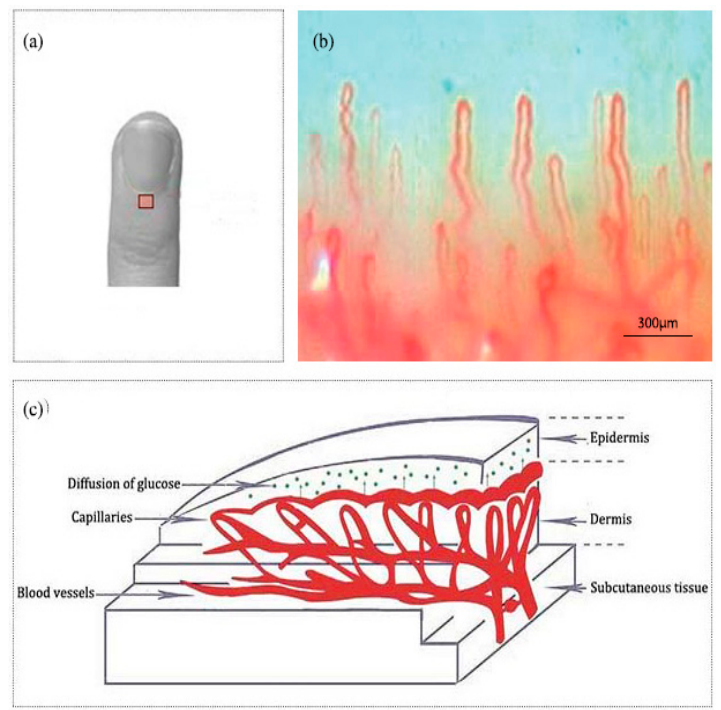
Figure 1. ( a ) A nailfold for the fourth finger including an area to be scanned. ( b ) The image of nailfold by the microcirculation detector. ( c ) Schematic of the nailfold skin with epidermis, dermis and subcutaneous tissue.